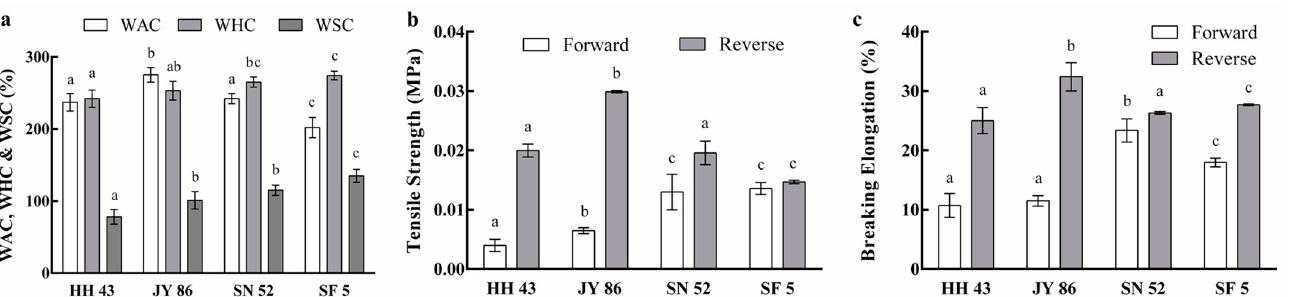
Figure 2. Processing characteristics of four kinds of plant-based meat analogues (PBMs): ( a ) WAC, WHC, and WSC of four kinds of PBMs; ( b ) TS of four kinds of PBMs; ( c ) BE of four kinds of PBMs. Different lowercase letters indicate a significant difference [ p < 0.05]). HH 43: Heihe 43, JY 86: Jiyu 86, SN 52: Suinong 52, SF 5: Shengfeng 5, WAC: Water-Absorption Capacity, WHC: Water-Holding Capacity, WSC: Water-Swelling Capacity, TS: Tensile Strength, BE: Breaking Elongation. Table 4. Texture characteristics of four kinds of plant-based meat analogues (PBMs).